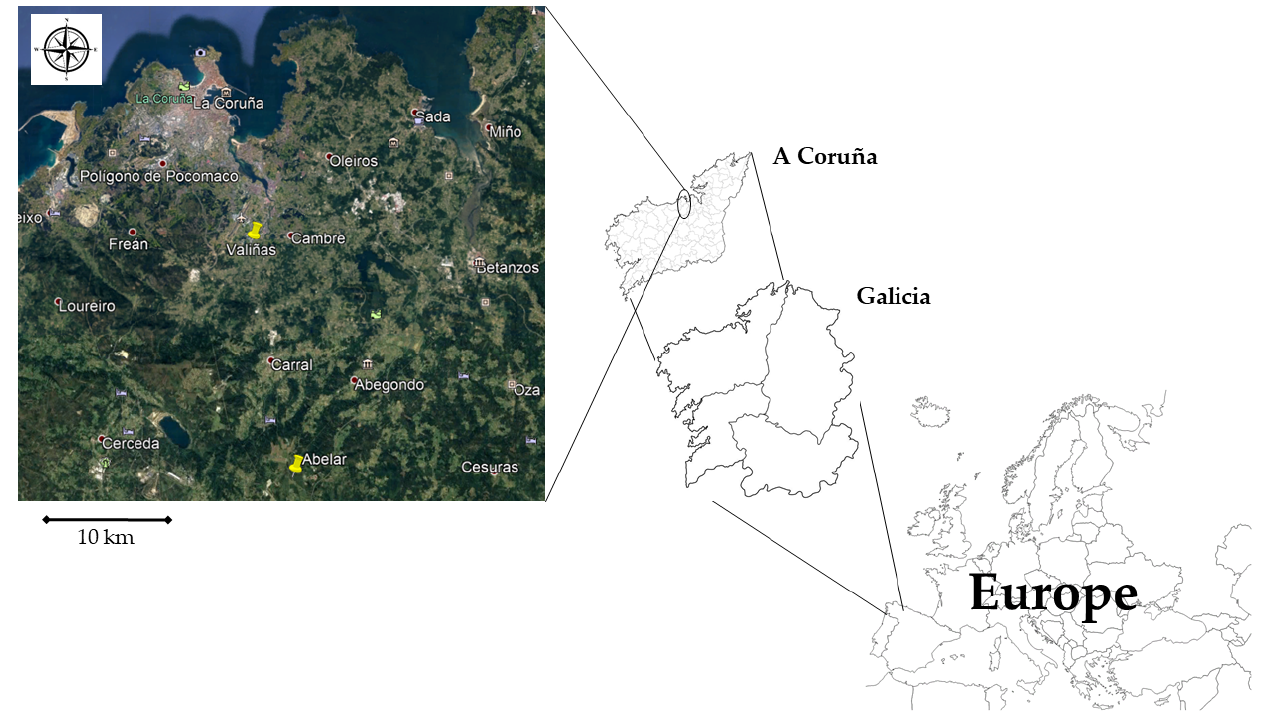
Figure 1. Location of the studied catchments (yellow marks) in the northwest of Spain. The Valiñas River is a small headwater stream with a catchment that is 36.3 km 2 in surface. Topographically, this catchment consists of steep uplands and contrasting lowlands or local small plains. The bedrock consists of granite (85%) and some outcrops of schists (15%) from the Ordes series in the Northeast of the catchment [20]. The soils